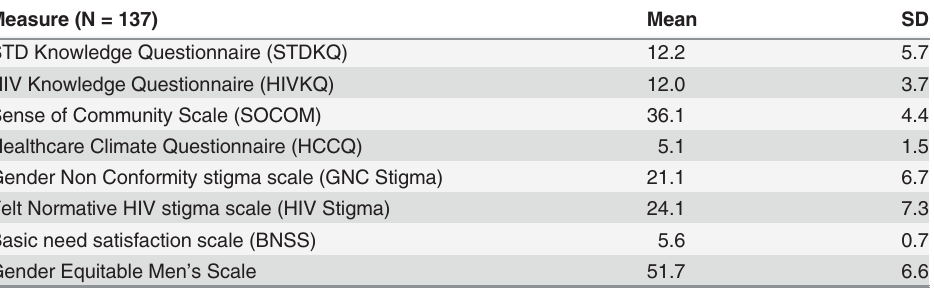
Table 3. Summary of psychosocial variable scores for overall sample.